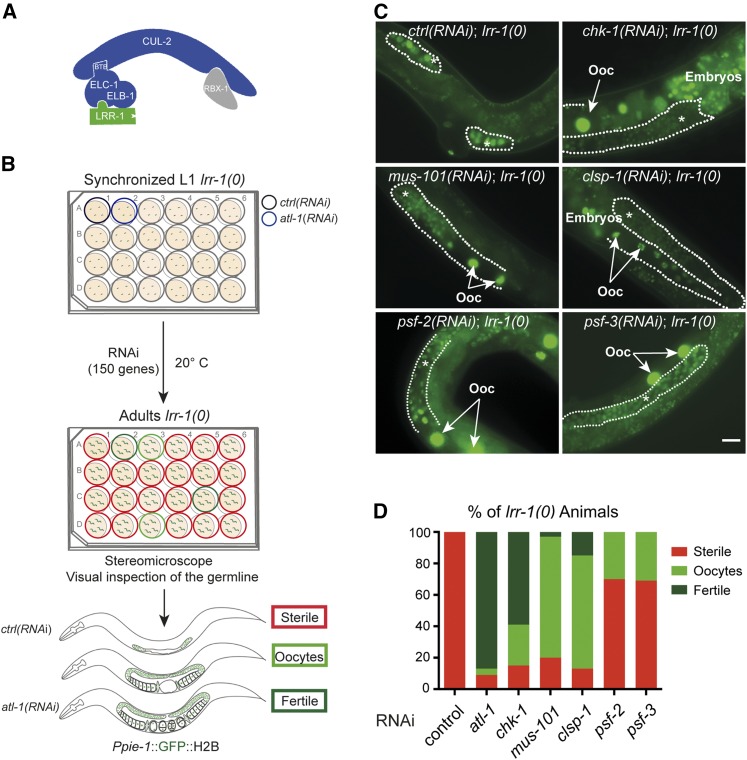
A visual RNAi-based screen for lrr-1(0) suppressors. (A) Schematic representation of the CRL2LRR-1 E3-Ligase. The evolutionarily conserved Leucine Rich Repeat protein LRR-1 (green) acts as a substrate-recognition subunit of Cullin-RING E3-ligase nucleated around CUL-2 (blue). ELC-1, in complex with ELB-1 (blue), serves as an adaptor and RBX-1 (gray) is the catalytic subunit. (B) Flow-chart of the visual RNAi-based screen for lrr-1(0) suppressors. Synchronized lrr-1(0)/+ (not shown for simplicity) and lrr-1(0) L1 larvae expressing GFP::H2B in the germline were fed in several 24-well NGM plates until adulthood with bacteria expressing dsRNA targeting 150 genes involved in cell cycle control and DNA metabolism. Each plate contained a negative (ctrl(RNAi)) and a positive control (atl-1(RNAi)). The morphology of the germline of lrr-1(0) animals exposed to RNAi clones was visualized under a stereomicroscope equipped with fluorescence. The bottom panel shows a schematic representation of lrr-1(0) animals exposed to mock or atl-1(RNAi). lrr-1(0) animals exposed to mock RNAi are fully sterile with a small germline (red rectangle) whereas lrr-1(0) animals exposed to chk-1 or atl-1(RNAi) produced gametes and embryos (dark green rectangle). In cases where the suppression is incomplete, the lrr-1(0) animals produce oocytes but no embryos (light green rectangle). (C) Representative fluorescence images of lrr-1(0) animals expressing the GFP::H2B transgene upon inactivation of the indicated genes. An asterisk and dotted lines indicate the position of the germ line. White arrows mark the position of the oocytes. Scale bar: 20 μm. (D) Graphs showing the percentage of lrr-1(0) animals, exposed to the indicated RNAi, presenting the different phenotypes: sterile animals with a small germline (red), animals producing oocytes (light green), fertile animals (dark green). More than 50 worms were analyzed in each condition.